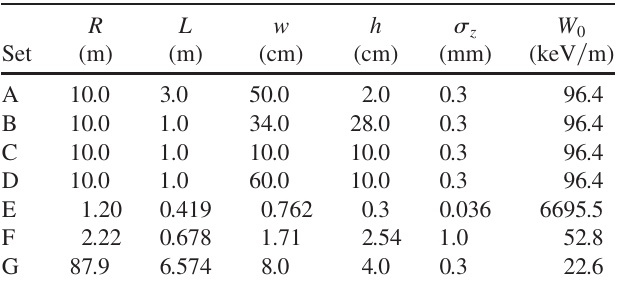
TABLE I. Parameters used in